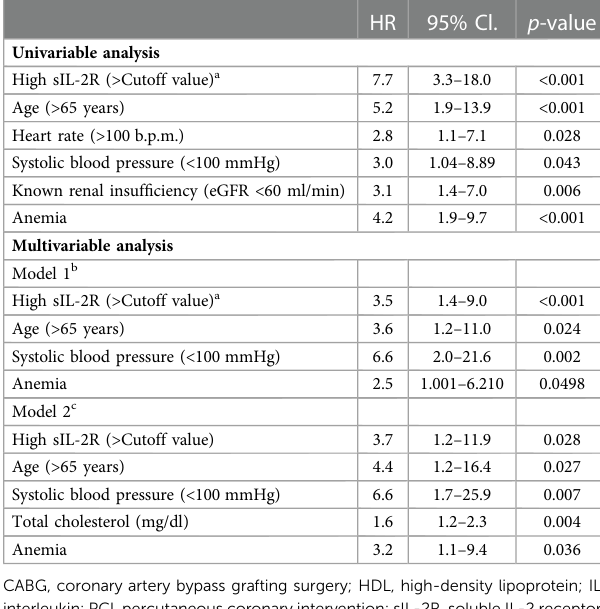
TABLE 2 Univariable and multivariable HR of high sIL-2R for MACEs at 1- year follow-up.